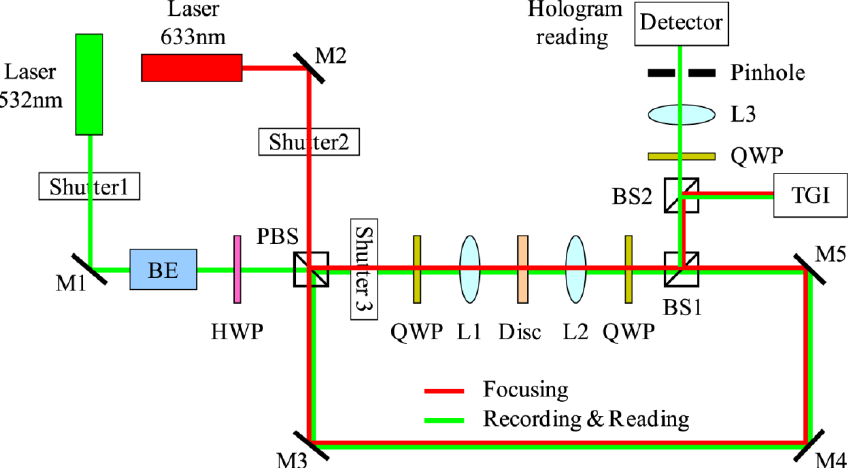
Figure 6. Experimental set-up for MHSS. BE: beam expander, M, mirror; L, lens; BS, beam splitter; PBS, polarization beam splitter; HWP, half wave plate; QWP, quarter wave plate. Green, recording and reading beam; Red, guide beam for optical alignment.